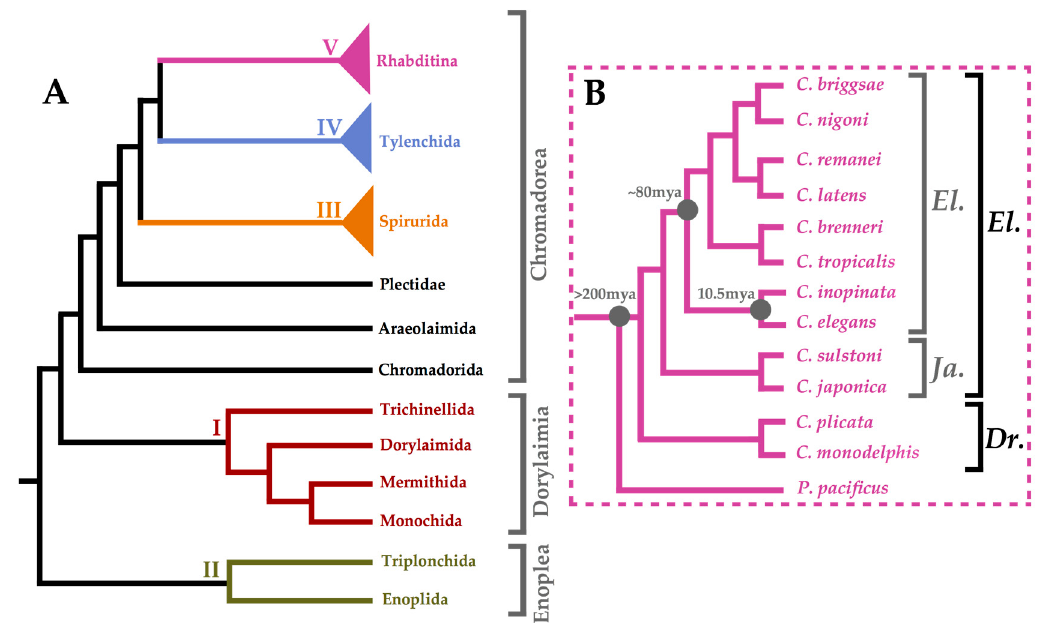
Figure 1. Phylogenetic Summary of Nematoda. Panel ( A ) shows a dendrogram summarising the results of Blaxter et al.'s maximum parsimony analysis as well as the maximum likelihood analysis performed by Smythe et al. on nematode orders [18,19]. Clades I–V are colour-coded: I (burgundy), II (olive), III (orange), IV (light blue), and V (purple). Panel ( B ) shows a summary dendrogram of the Caenorhabditis genus adapted from Bayesian analysis by Stevens et al. [22]. All species are in the Caenorhabditis genus and rooted with a Pristionchus pacificus outgroup. The Elegans ( El. ) and Drosophilae ( Dr. ) supergroups are depicted (black) as well as the Elegans ( El. ) and Japonica ( Ja. ) groups (grey) therein.